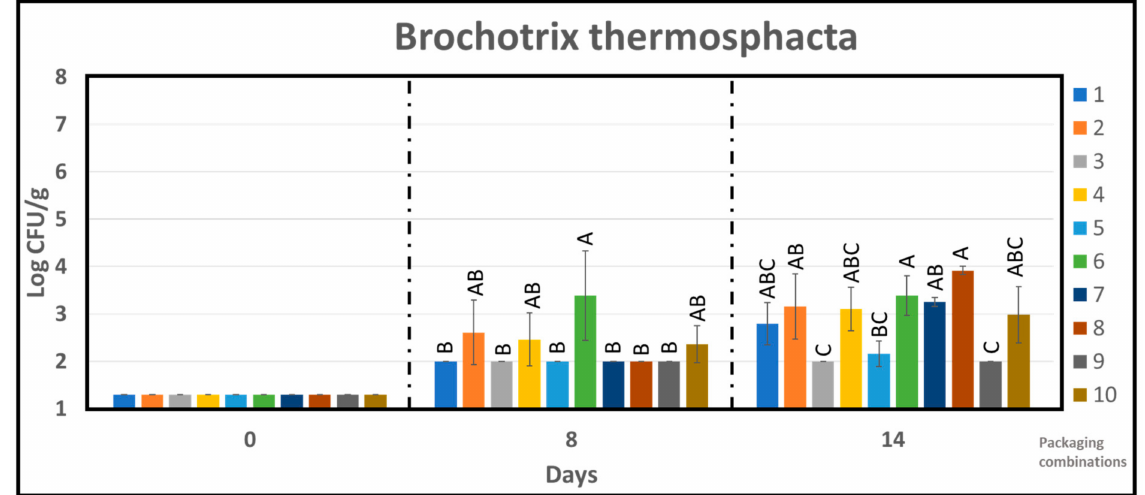
Figure 6. The effect of packaging combinations on the Brochotrix thermosphacta counts in chicken samples during storage time of 14 days. One-way analysis of variance Tukey comparison is performed separately at sampling point 8 and 14. Tukey group is represented by upper case letters, samples which do not share the same letter are significantly different.